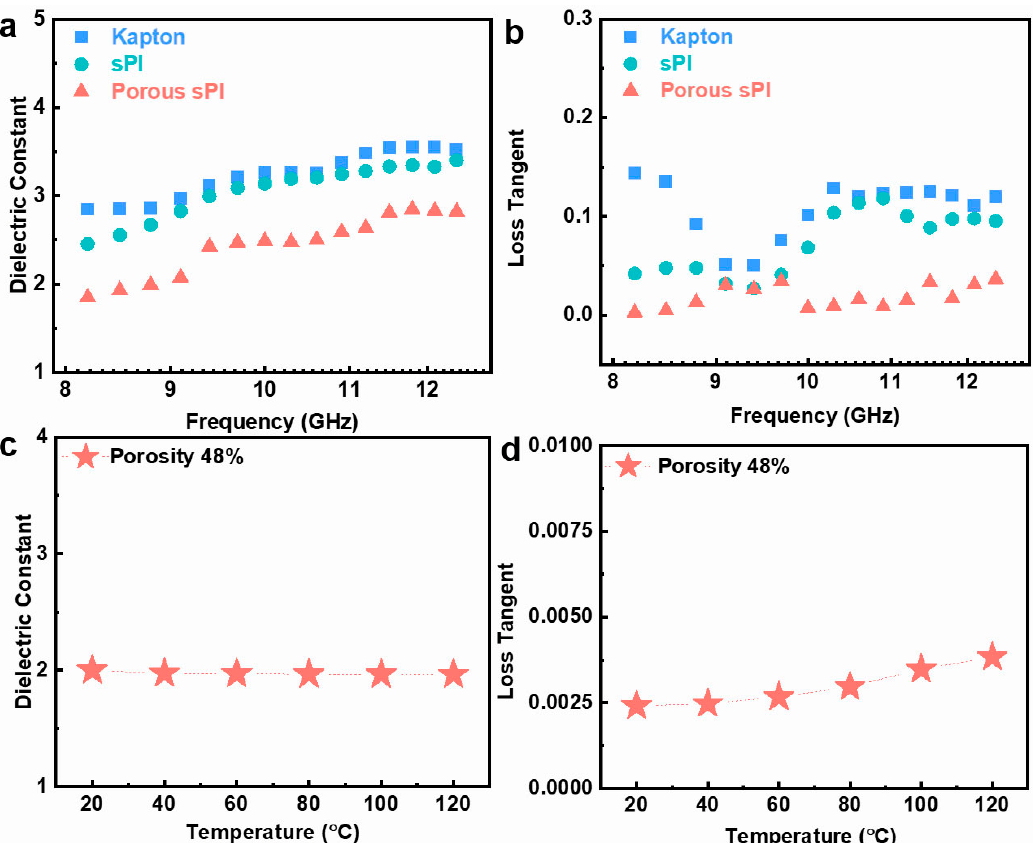
Figure 5. Dielectric properties of sPI films under GHz and various temperatures: ( a , b ) the dielectric constant and loss tangent of Kapton film, dense sPI film, and porous sPI film (with the porosity of 48%) in the frequency range of 8.2–12.5 GHz; ( c , d ) the variation in dielectric constant and loss tangent of the porous sPI film at 10 5 Hz with the temperature.